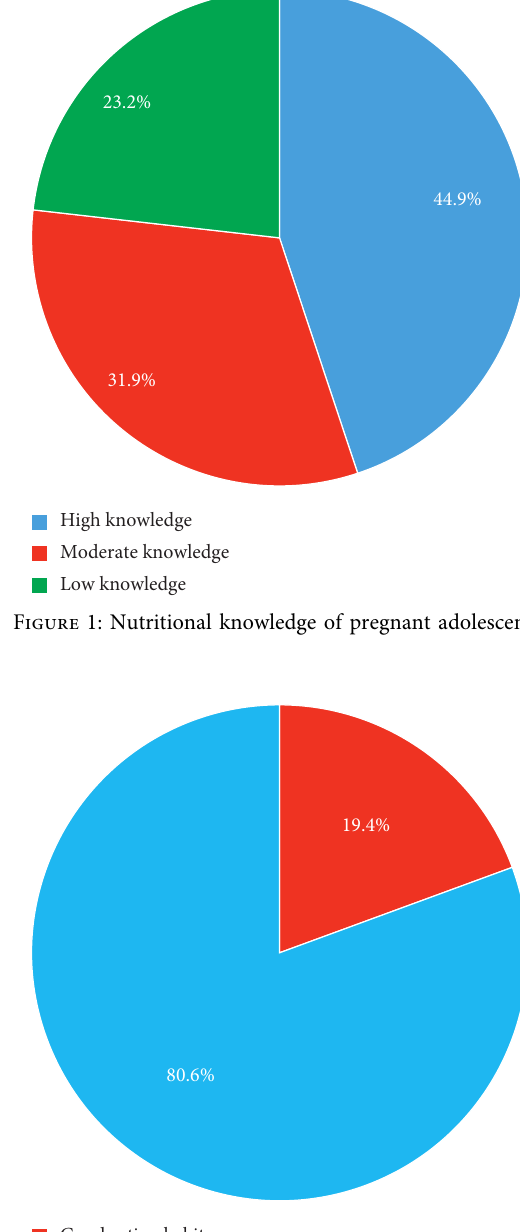
Table 1: Demographic characteristics of